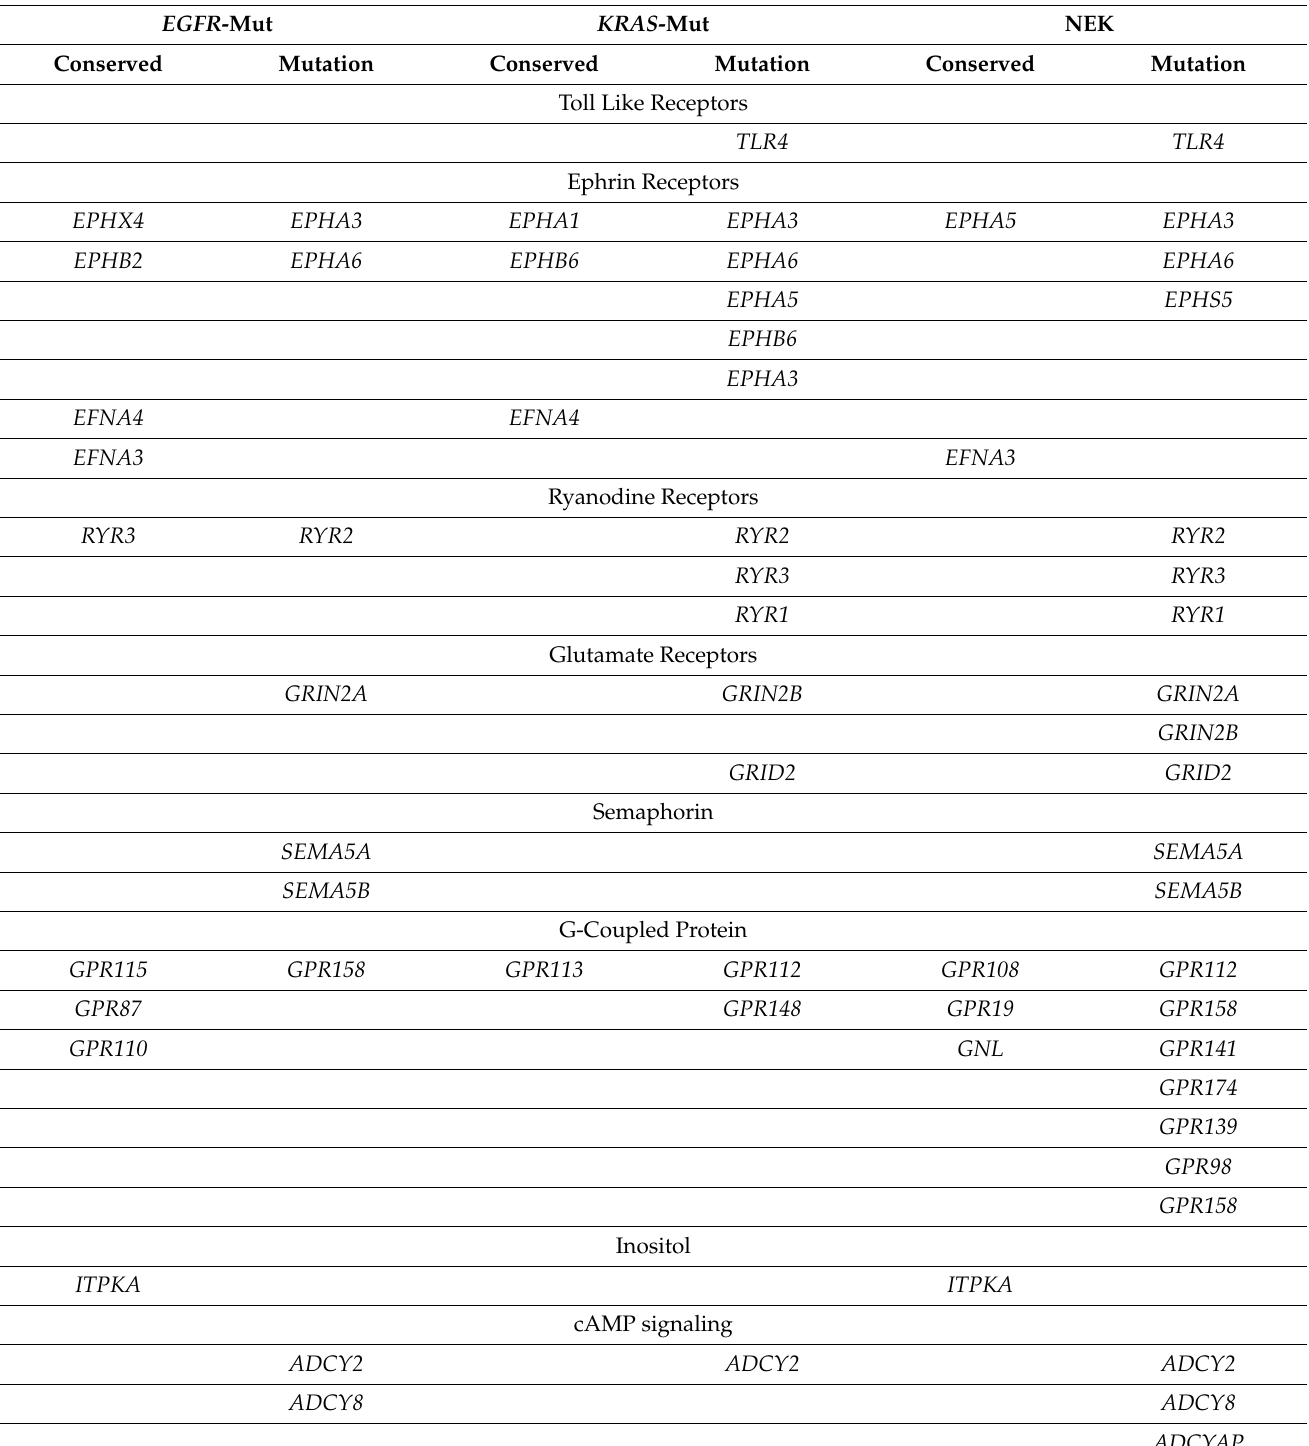
Table 1. Cont. Evolutionary Selection for Mutations or Conservation in Intracellular Pathways EGFR -Mut Conserved